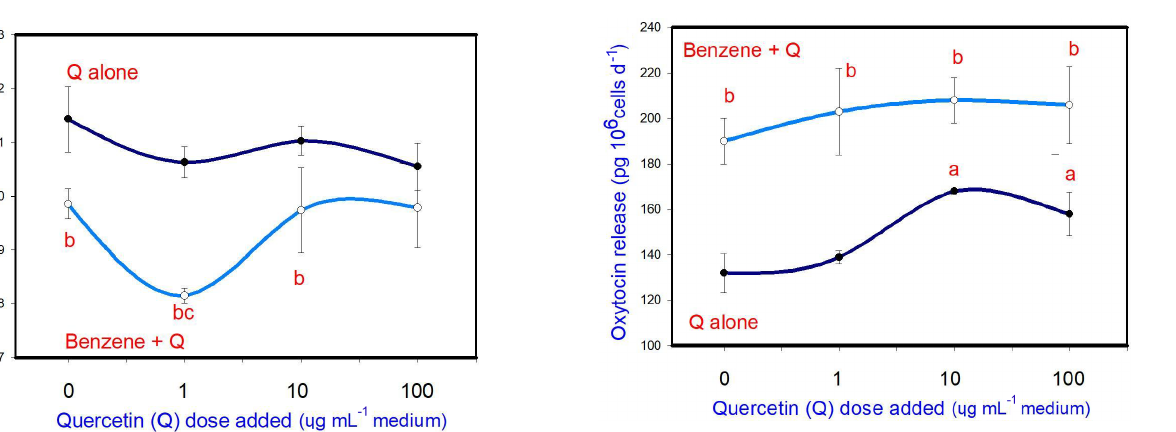
Figure 3. Effects of benzene, quercetin extract, and their combi- nation on the release of progesterone in cultured porcine ovarian granulosa cells. Parts marked “a” show the effect of quercetin ex- tract (significant difference ( P< 0 . 05) between cells cultured with- out and with quercetin addition at three different levels without ben- zene), b the effect of benzene (significant difference ( P< 0 . 05) be- tween cells cultured with or without benzene for each quercetin dose separately), c the effect of quercetin extract at simultaneous benzene presence (significant difference ( P< 0 . 05) between a cell cultured with and without quercetin addition at three different lev- els with simultaneous benzene addition); effect of benzene alone (20µgmL − 1 ) is displayed for quercetin dose at 0µgmL − 1 .